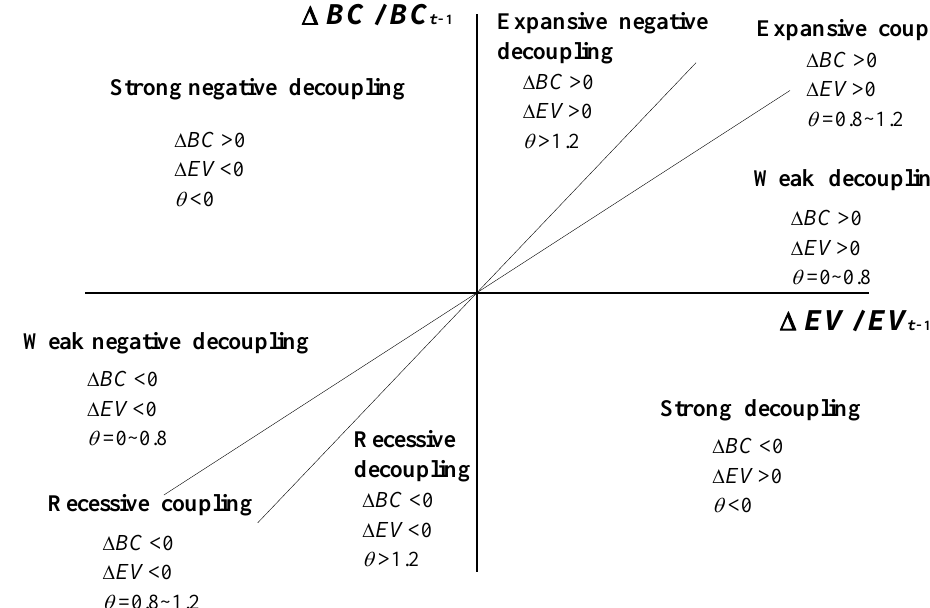
Figure 1. Classifications of decoupling states in the Tapio decoupling model.